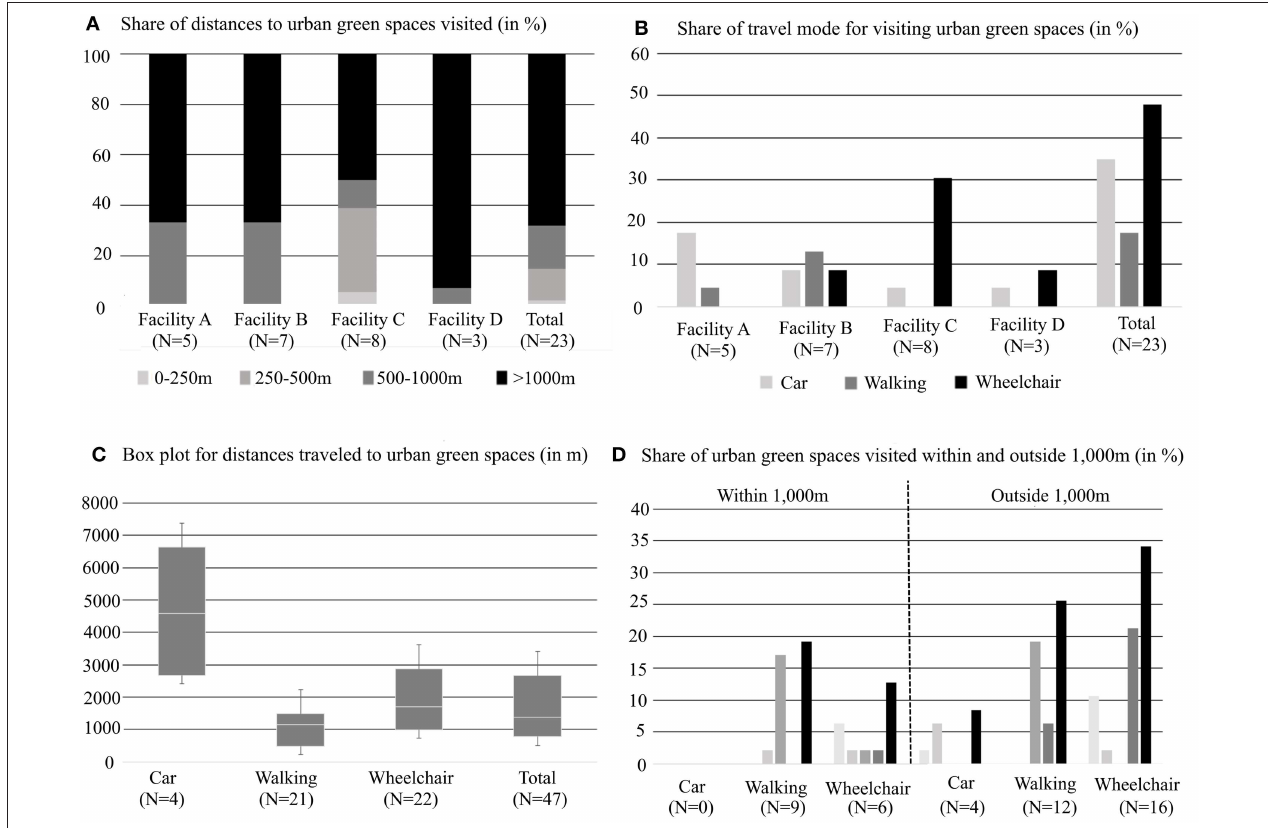
FIGURE 2 | Actual accessibility to urban green spaces. (A) Share of distances to urban green spaces visited (in %). (B) Share of travel mode for visiting urban green spaces (in %). (C) Box plot for distances traveled to urban green spaces (in m). (D) Share of urban green spaces visited within and outside 1,000 m (in